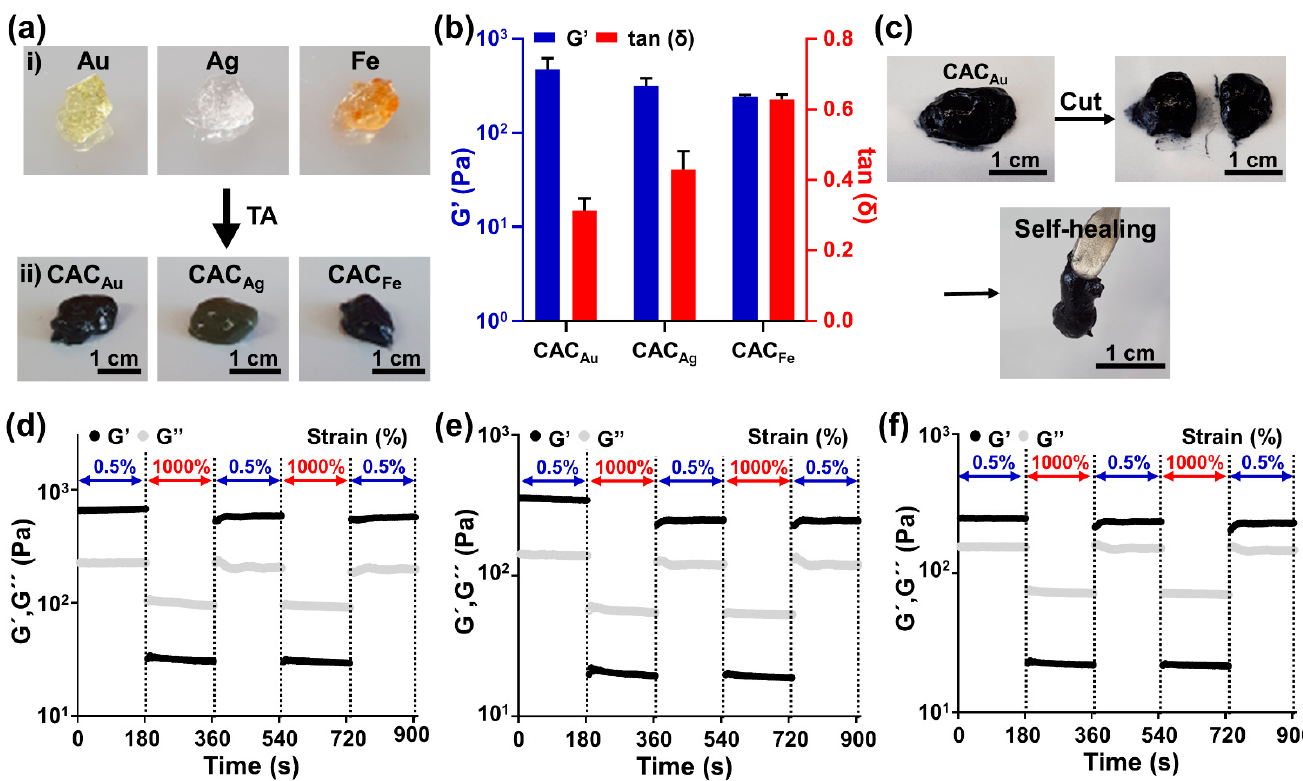
Figure 3. Fabrication and mechanical characterization of CAC hydrogels. ( a ) Digital images of (i) the CMC and metal ion mixture and (ii) CAC Au , CAC Ag , and CAC Fe . ( b ) Comparison of the storage modulus (G’, blue) and tan( δ ) (red) values among CAC Au , CAC Ag , and CAC Fe . ( c ) Macroscopic self-healing images of CAC Au . ( d – f ) Evaluation of the disruption and recovery of the storage (G’) and loss (G”) moduli under alternating strains of 0.5% and 1000%: ( d ) CAC Au ; ( e ) CAC Ag ; ( f ) CAC Fe . Table 2. Precursor compositions of different CAC hydrogels.